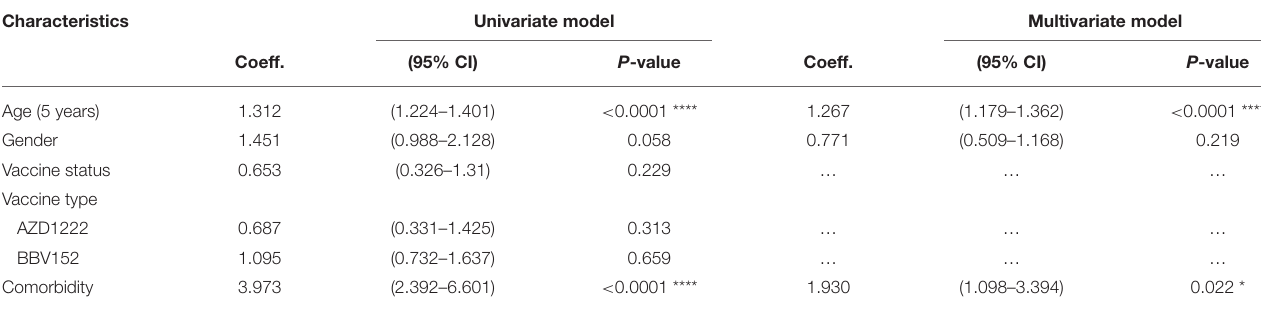
TABLE 2 | Clinical and demographic characteristics associated with hospitalization.